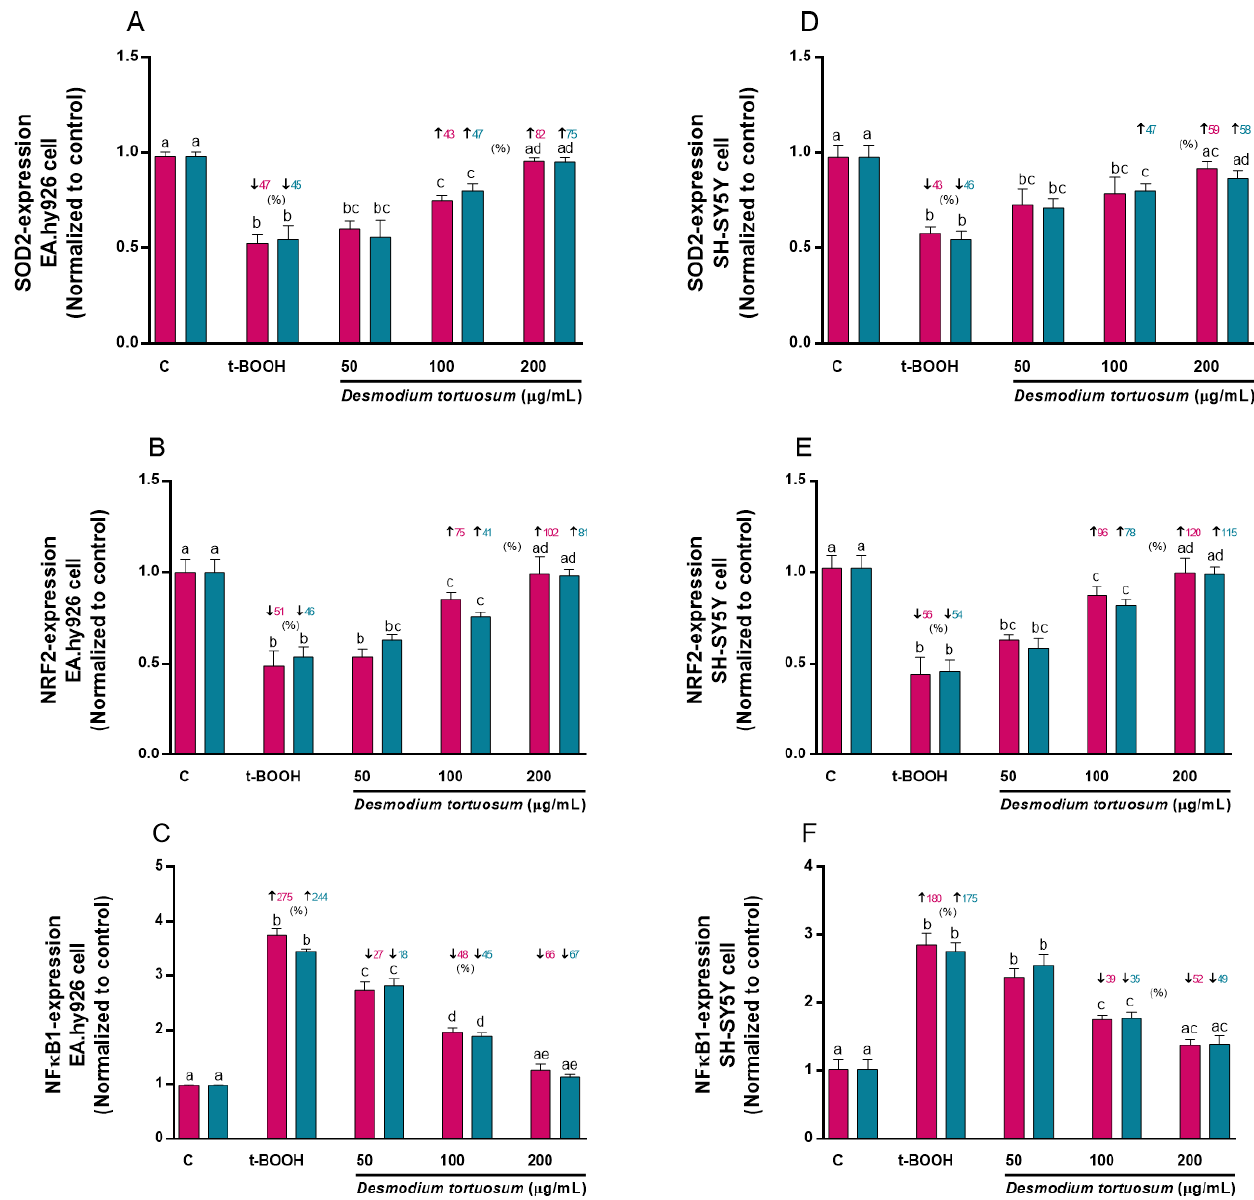
Figure 10. Effect of D. tortuosum extract (50, 100, and 200 µM) on the expression of oxidative- antioxidative genes (SOD2, NRF2, NFκB1) in EA.hy926 ( A – C ) and SH-SY5Y ( D – F ) cells after 24 h co-treatment (red bars, █ ) and pre-treatment (blue bars, █ ) periods. The gene expression was determined as control-normalized value, and represented as the mean ± SEM of four independent experiments. a,b,c,d Different letters show significance between groups at p < 0.05. ↓ represents percentage decrease or ↑ represents percentage increase with respect to control or with respect to t-BOOH.